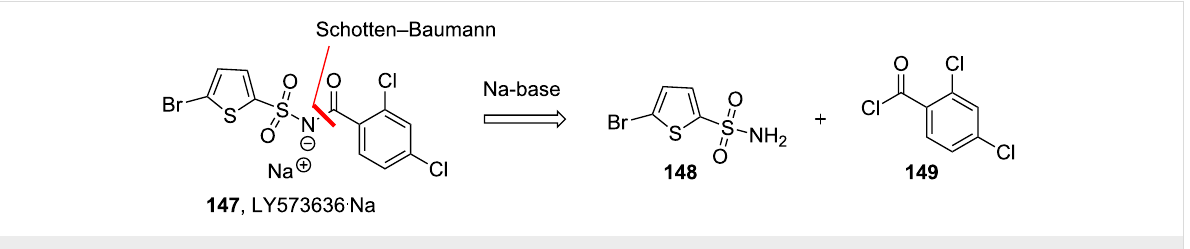
Figure 6: Schotten–Baumann approach towards LY573636 . Na ( 147 ).